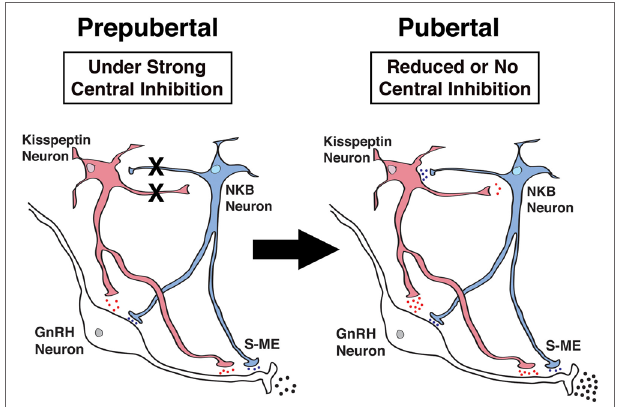
FiGURe 3 | Schematic diagram showing the developmental changes in kisspeptin (red) and neurokinin B (NKB) (blue) signaling to GnRH neurons in the stalk-median eminence (S-ME) in prepubertal ( left panel ) and pubertal ( right panel ) female monkeys. Note that X’s between kisspeptin and NKB neurons indicate the absence of signaling pathways and the blue, red and black dots indicate relative amount of neuropeptide release. Kisspeptin signaling to NKB neurons is hypothetical, as in the present study, we did not measure the kisspeptin-induced NKB release. Modified from Ref. (35) with Copyright